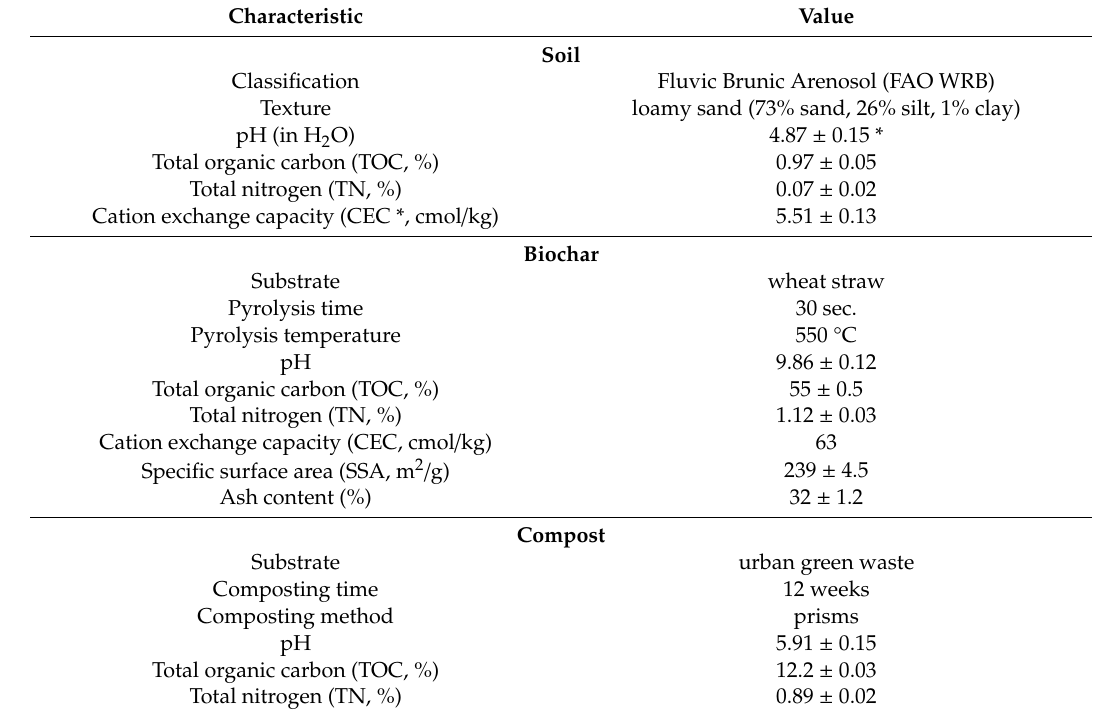
Table 1. Properties of soil, biochar and compost used in the